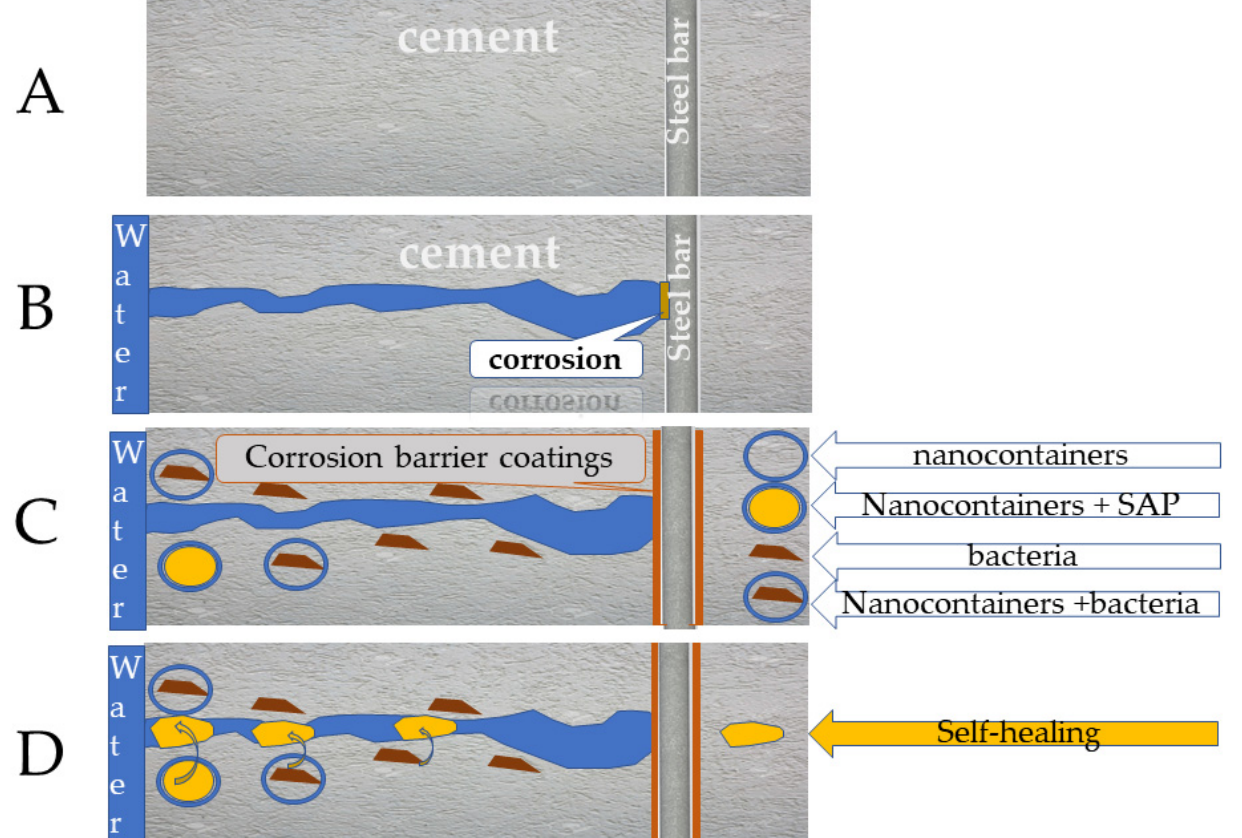
Figure 10. Self-healing mechanism in concrete via bacteria and SAP in nanocontainers. ( A ) Concrete; ( B ) Concrete with crack, water induces corrosion on steel; ( C ) Concrete with bacteria, SAP, Nanocontainers filled with SAP or Bacteria; ( D ) Self-healing.